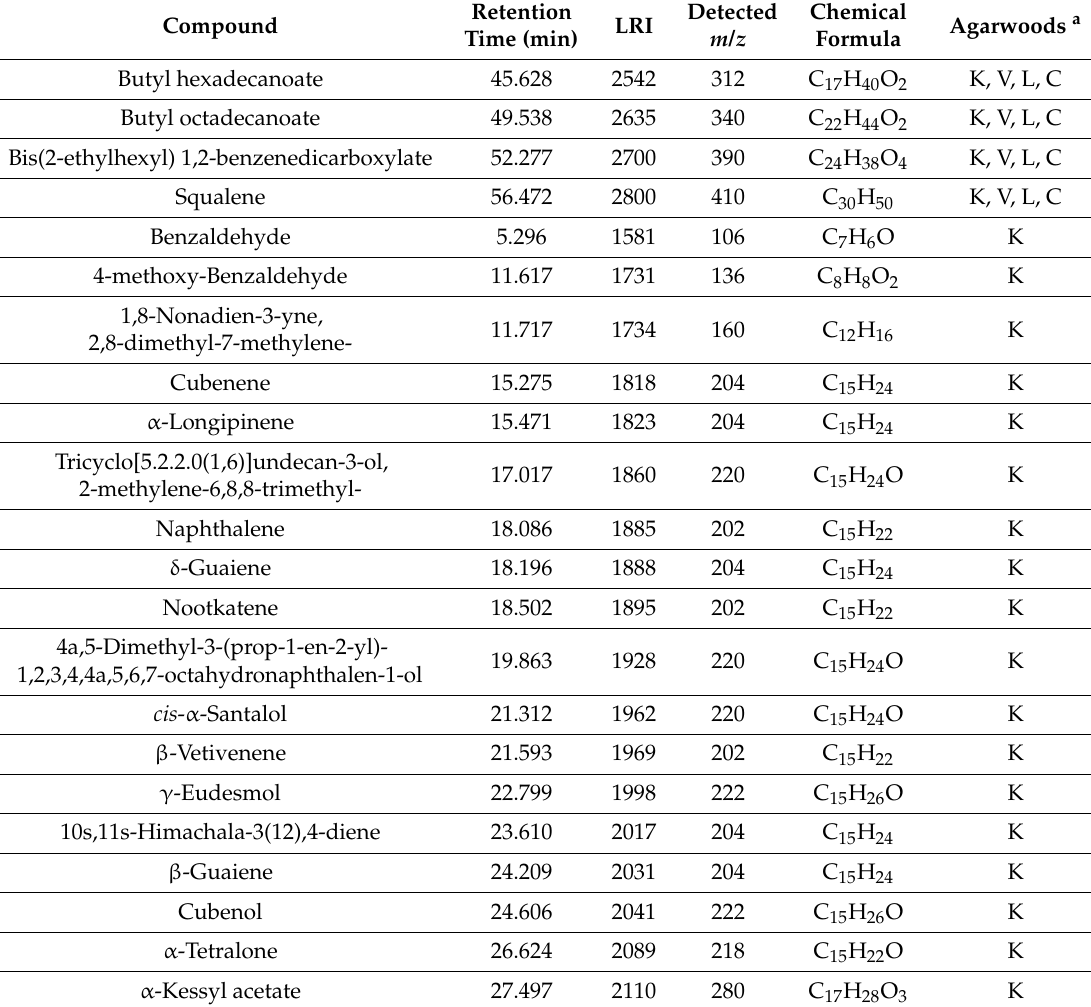
Table 2. Compounds commonly or specifically present in the incense smoke of